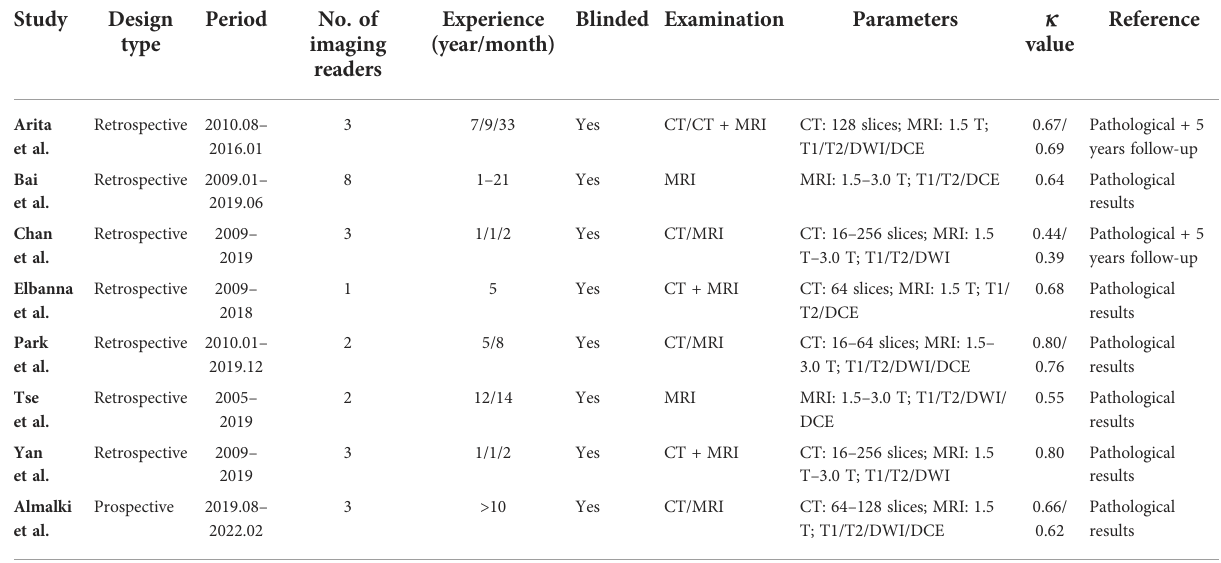
TABLE 2 Characteristics of the included